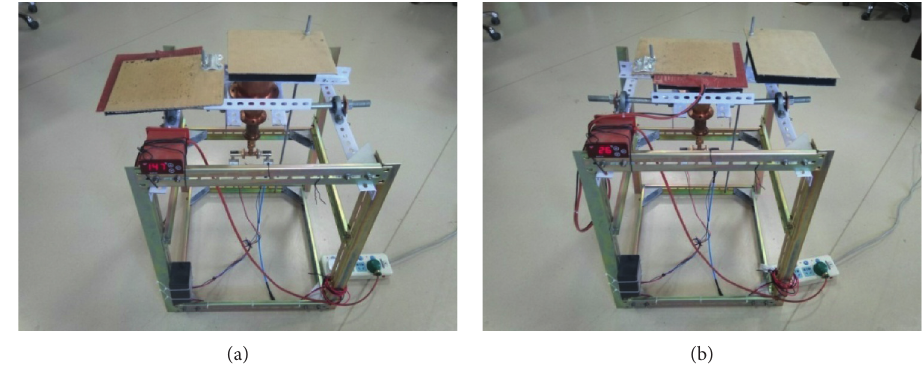
Figure 12: K-band ambient and hot load calibration system.